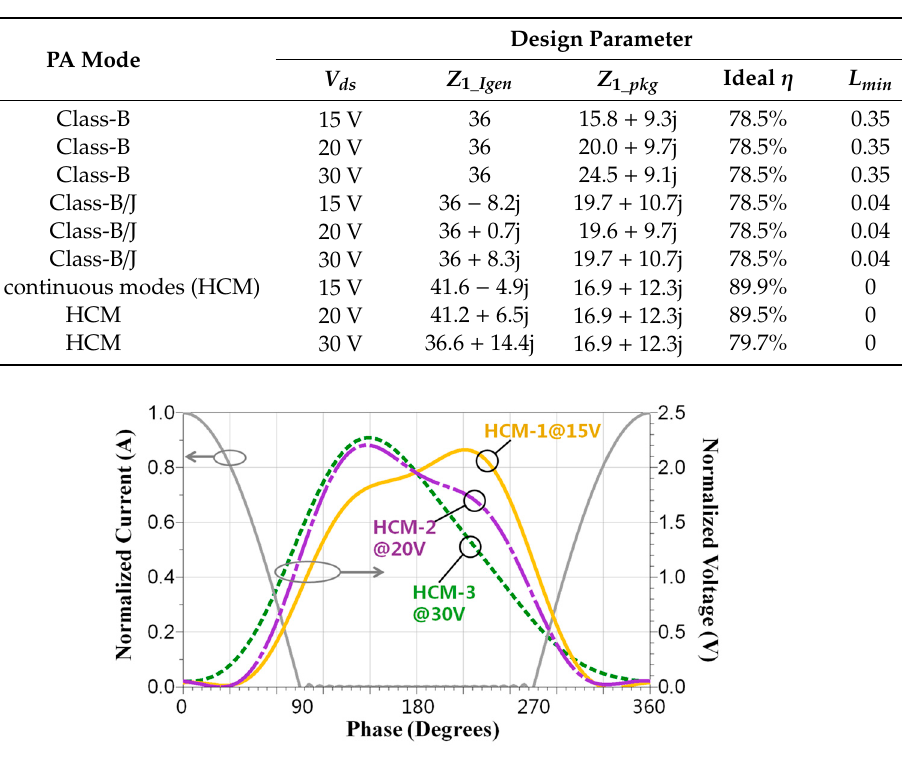
Table 1. Calculated results of power amplifier (PA) design parameters.